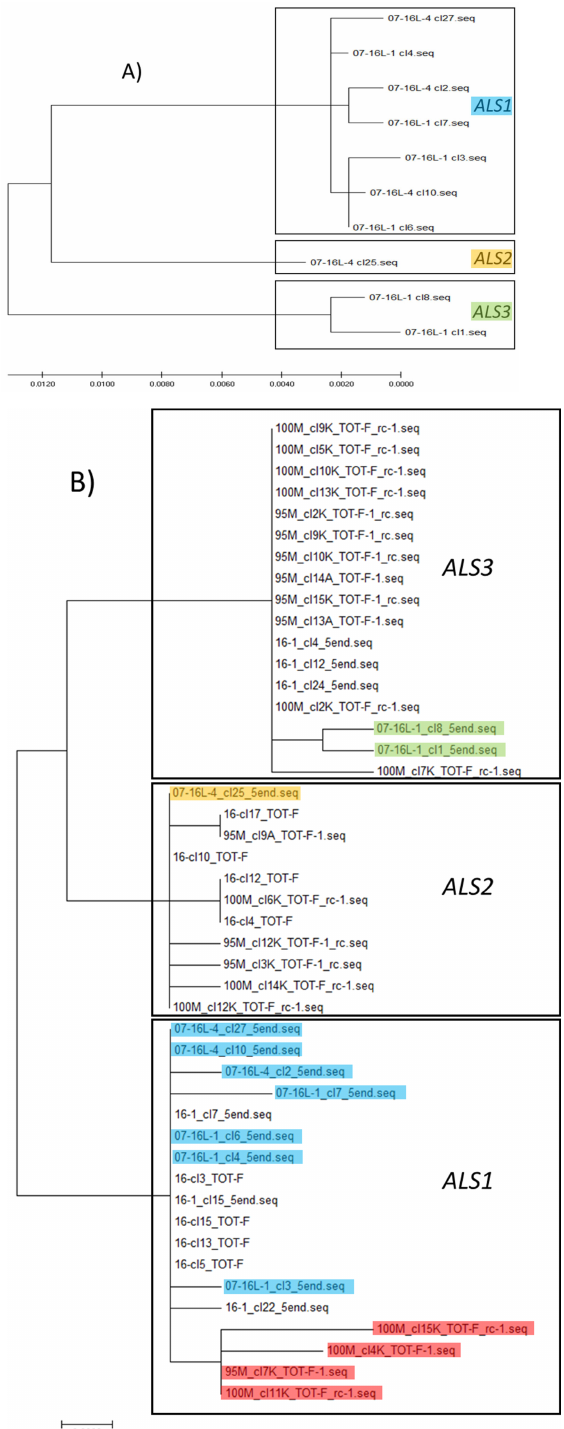
Figure 5. ( A ) Cladogram obtained from UPMGA estimation of full-length clone sequences, five of the plant 16L-1 and five of the plant 16L-4 (both plants of S E. crus-galli population 16S) using MEGA X ® ; these clones were used to define the different ALS gene copies in the R populations of the E. crus-galli species; ( B ) cladogram obtained from UPMGA estimation of 46 ALS partial clone sequences starting from 5 (cid:48) -end belonging the E. crus-galli populations 16S, 95R and 100R, using MEGA X ® ; the mutated clones of E. crus-galli populations 95R and 100R are highlighted in red; the sequences of population 16S present in the cladogram of ( A ) are highlighted in blue ( ALS1 ), orange ( ALS2 ) and green ( ALS3 ), respectively, in the cladogram of ( B